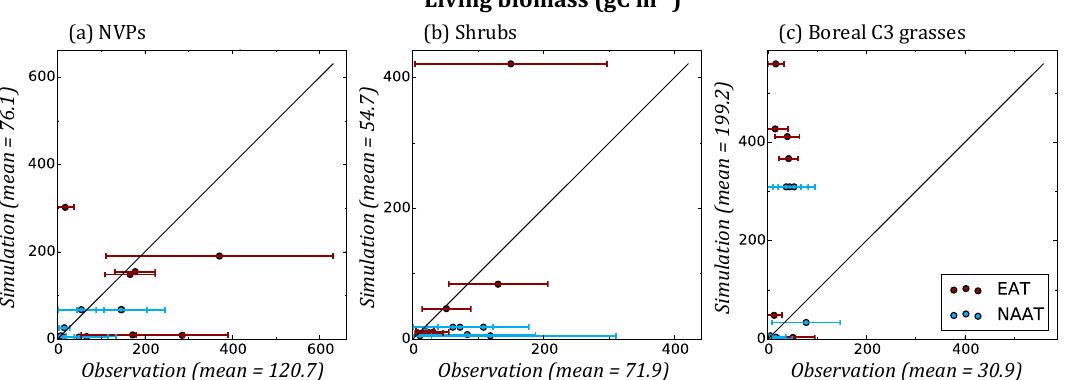
Figure 9. Model versus observed living biomass for NVPs (a) , shrubs (b) and cold climate grasses (c) , in two different transects: the North America Arctic Transect (in blue) and the Eurasian Arctic Transect (in red). The error bars represent the standard deviation of observations at each